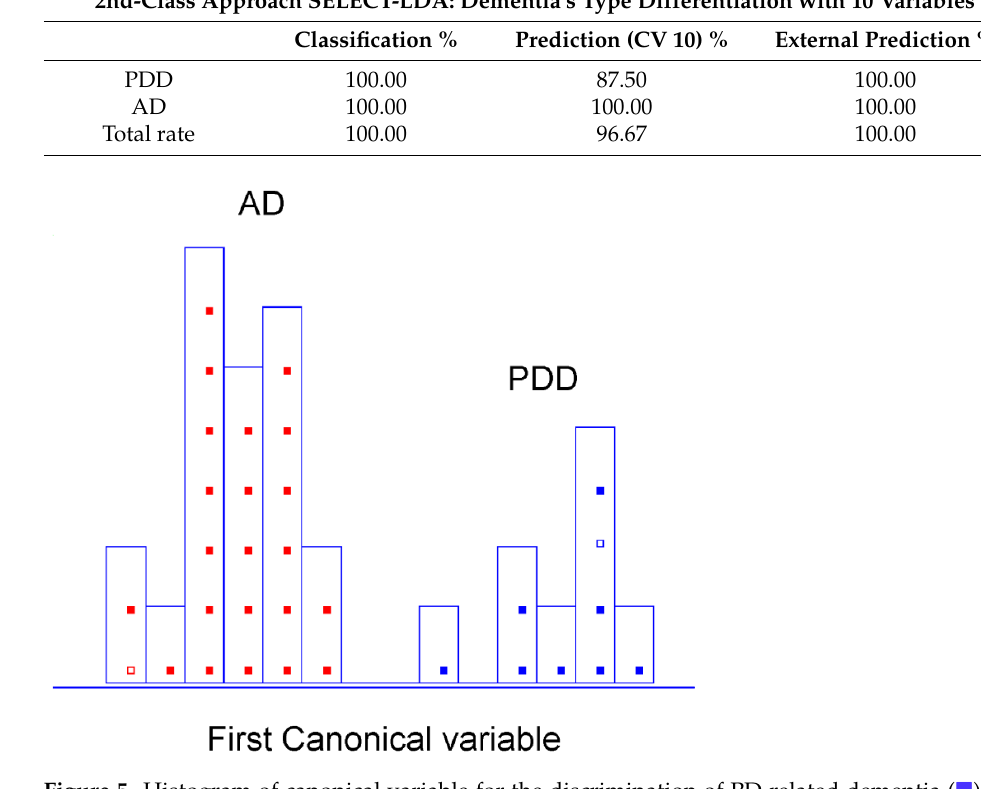
Table 5. Percentages of samples/patients classified correctly in both classification and internal/external validation in the SELECT-LDA performed when addressing the classification approach for dementia type differentiation.